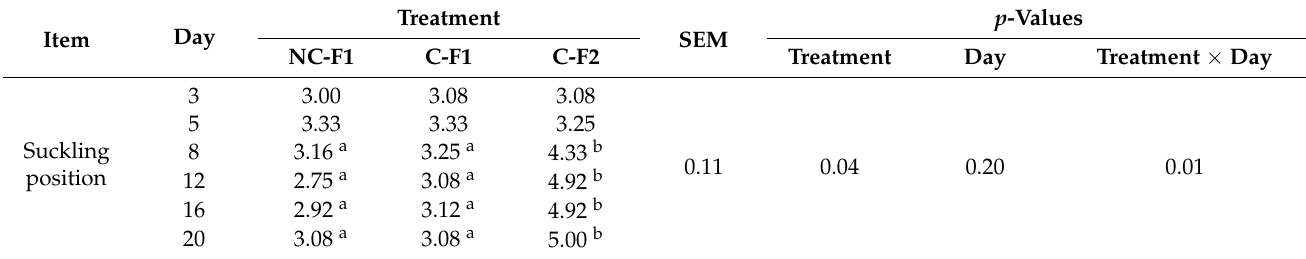
Table 3. Effect of different cross-fostering times on the suckling position of